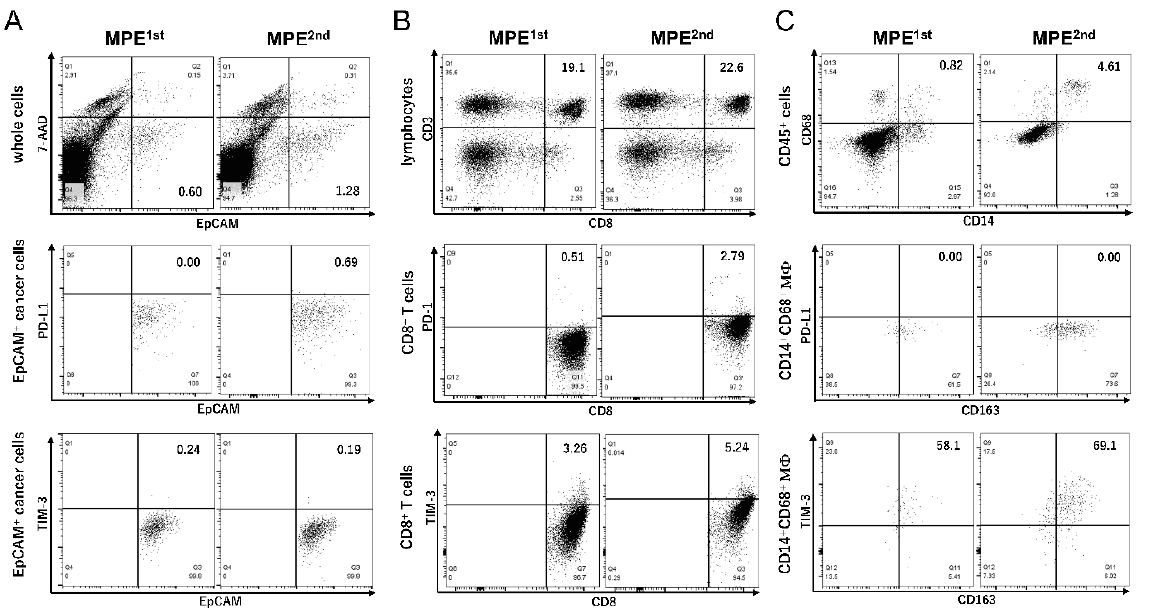
Figure 1. In MPE samples, there are immune checkpoint molecules on EpCAM + cancer cells, CD8 + T cells, and CD14 + CD68 + macrophages. ( A ) Representative flow cytometry plots for PD-L1 or TIM-3 expressions of EpCAM + cancer cells in malignant pleura effusion 1st and 2nd (MPE 1st , MPE 2nd ). ( B ) CD8 + T cells in CD45-SSC gating lymphocytes (MPE 1st , 19.1%; MPE 2nd , 22.6%) and PD-1 or TIM-3 expressions on CD8 + T cells in MPE. ( C ) Percentage of PD-L1 or TIM-3 expressions on CD14 + CD68 + macrophages (M Φ ) in CD45-SSC gating cells in MPE.